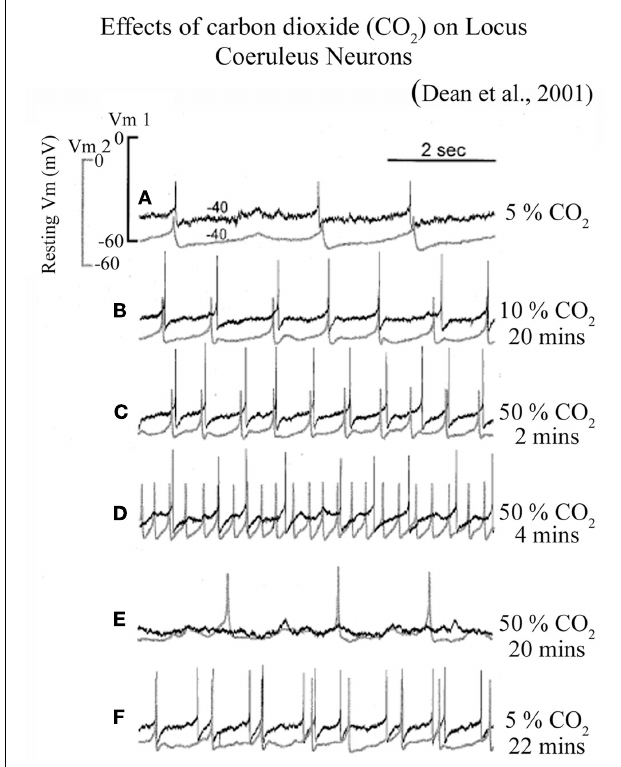
FIGURE 2 | Firing patterns of LC neurons at different CO 2 levels in slice preparation. Increased CO 2 level from (A) 5% control level to (B) 10% level for 20min and (C) 50% for 2min induced a graded stimulation of firing rate which remained synchronized between two neurons; (D) Prolonged exposure to 50% CO 2 for 4min disrupted synchronized firing; while (E) a continued exposure to 50% CO 2 for 20min completely hyperpolarized one of the cells; (F) The same neurons resumed their firing rate after exposing them to 5% CO 2 for 22min, although the lost synchrony was not regained. (Figure taken from Dean et al., 2001; after obtaining copyright permission from the Copyright clearance center, Elsevier Limited, UK through license number: